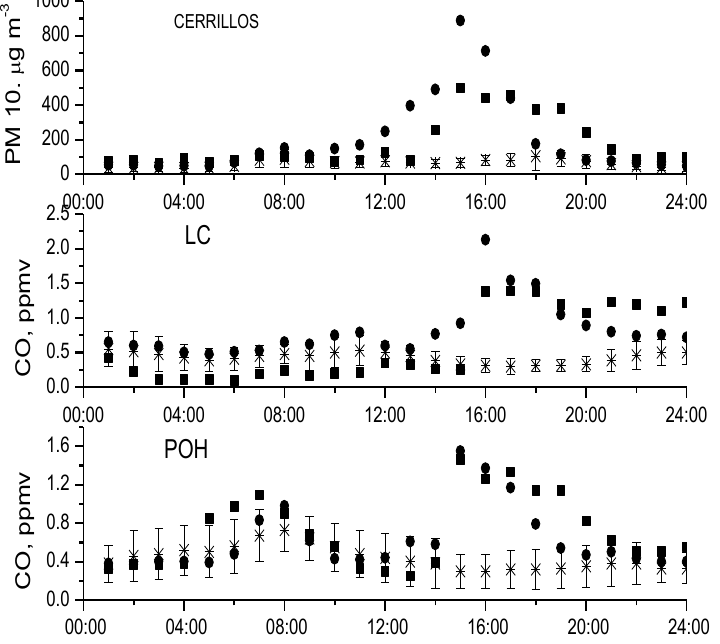
Figure 6. Comparison of data obtained in days with active fires (4 January 2014 and 8 January 2014) (▪,•) and the average of background data for days without fires during January 2014 ( ∗ ).